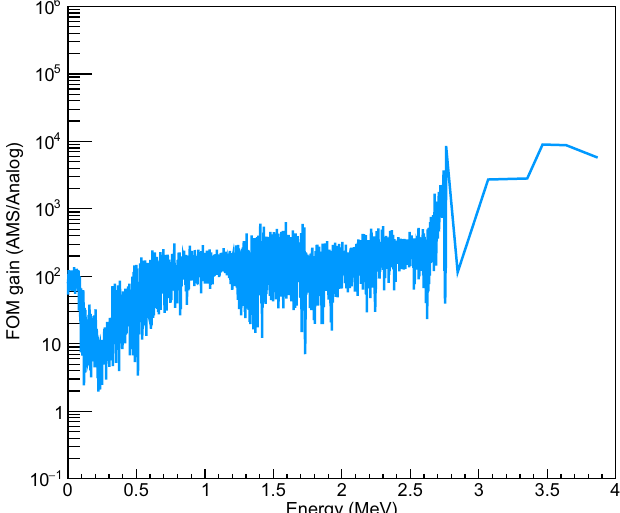
Fig. 10. Ratio of the AMS FOM over the analog FOM as a function of energy for the deposited